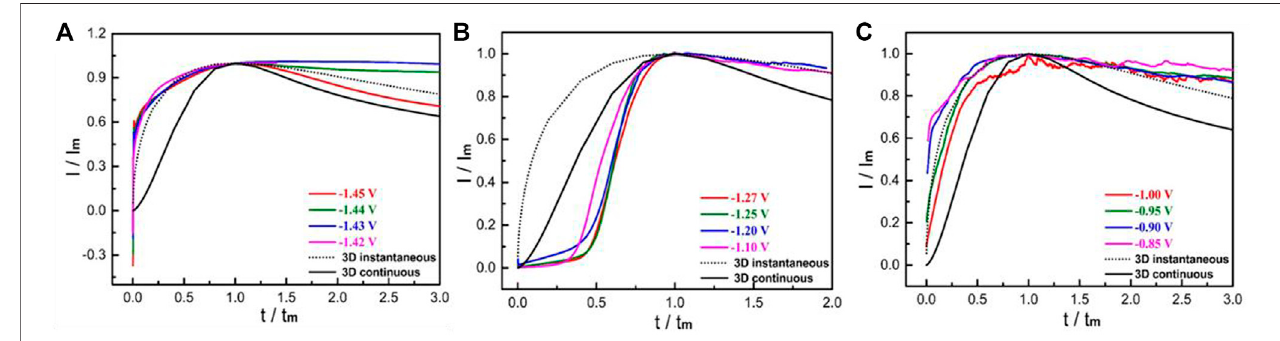
Figure 1B . The shape of the curve in this region was obviously different from that of the three other groups, that is, the current increased over time and no maximum current occurred in the testing process. This phenomenon is related to the overpotential on the electrode surface, and the low overpotential value is unfavorable to metal electrocrystallization (Hsiu et al., 2006). The curves shown in Figure 1C were evidently different from those of the other groups lies because of the “ current delay ” phenomenon (i.e., the current is almost zero) in the early testing stage. The corresponding delay time gradually decreased as the applied voltage signal increased. In Figure 1D , the response current fi rst reached the maximum value, rapidly decreased, and fi nally formed the peak current within a relatively short time.